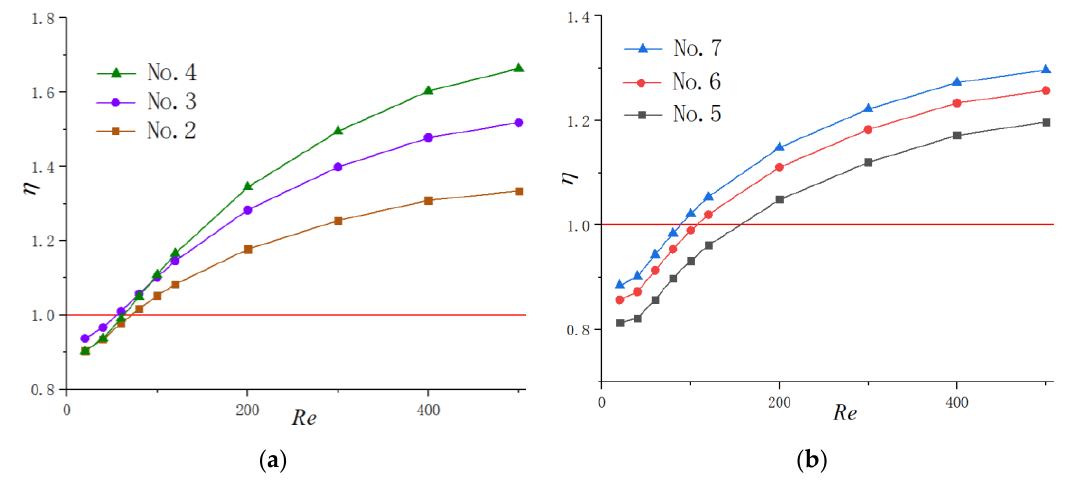
Figure 11. Variation of η with Re. ( a ) Group 1, ( b ) Group 2.